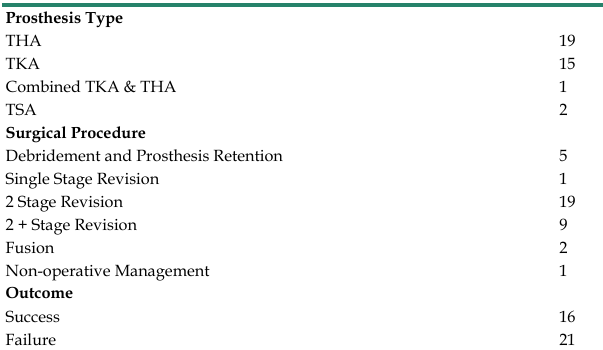
Table 2. Treatment Details Prosthesis Type THA